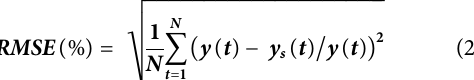
Table 1-Sample of hourly weather data for a typical day in January 2015.